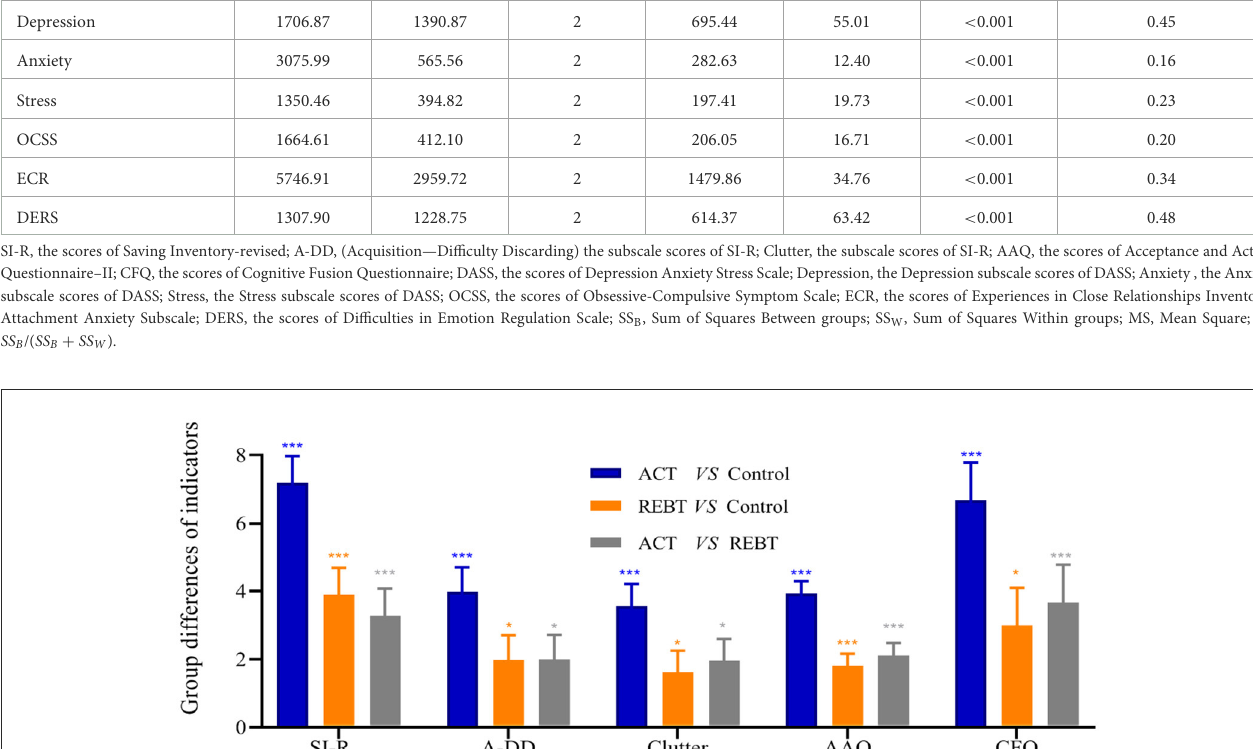
primary goal of ACT is to reduce cognitive fusion and experiential avoidance and increase psychological flexibility so that individuals can reduce their avoidance behaviors and act in accordance with their values (32, 36,